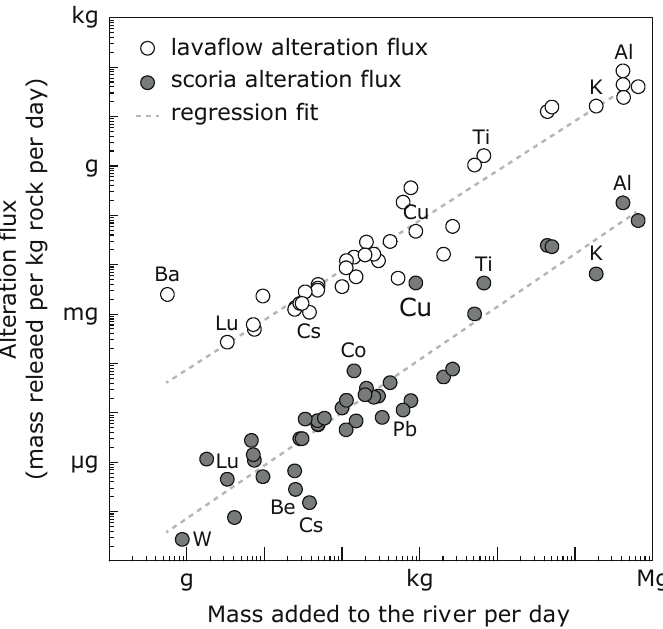
Figure 6. Change in upstream Banyu Pahit river water composition, corrected for dilution, compared to the alteration flux calculated from the experiments and from naturally altered Kawah Ijen andesitic lava.